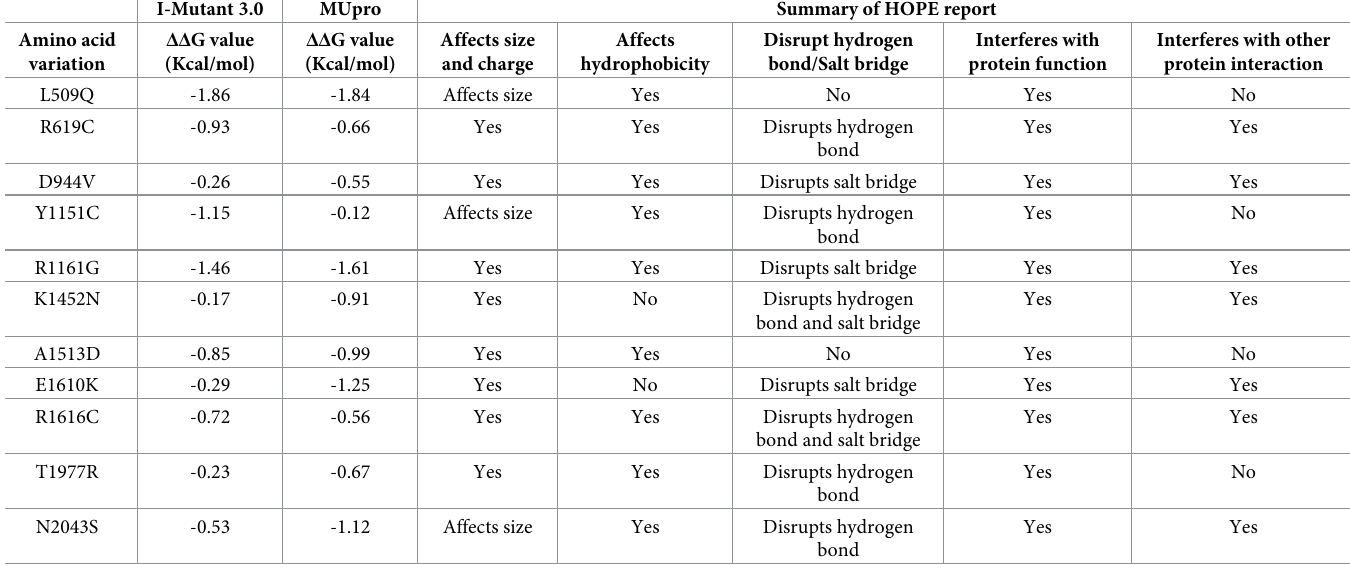
Table 3. The effect of the nsSNPs on mTOR protein’s stability as determined by I-Mutant 3.0 and MUpro and on structural features of the protein as determined by HOPE. I-Mutant